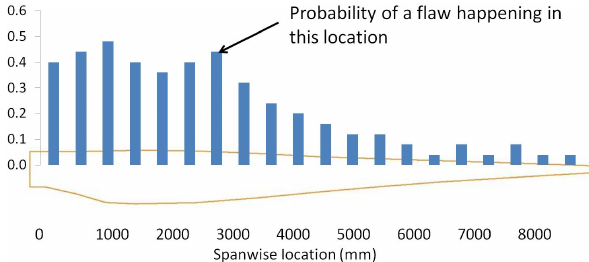
Figure 11. Probability mass of flaws at each blade